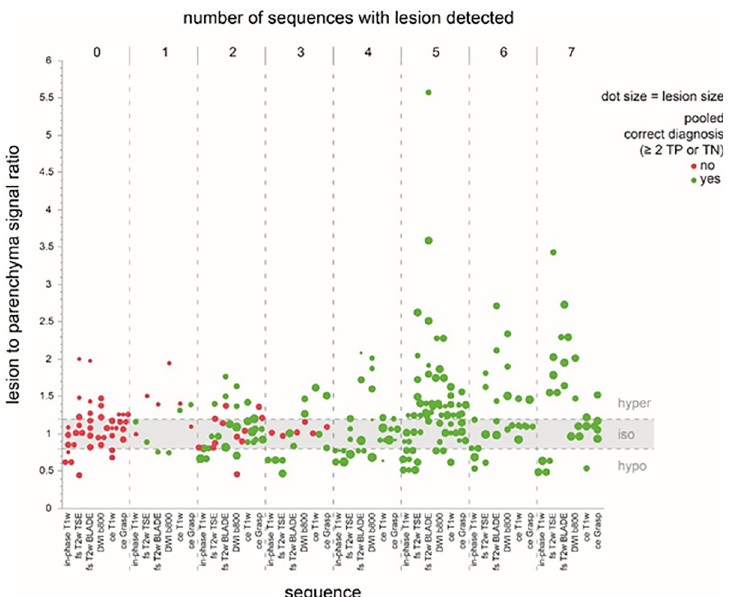
Fig 2. Relationship of number of sequences to correct diagnosis. The graph shows the number of sequences a lesion was detected on in relation to the measured lesion to parenchyma signal ratio. The higher the number of sequences a PICT was identified on, the more often a correct diagnosis was made. If a lesion was detected on four or more sequences, there was no missed lesion. This indicates increasing confidence in declaring a lesion to be present if detected on a larger number of sequences. Furthermore, the majority of missed lesions resides in the “iso” signal ratio corridor indicating poorly visible lesions. Correct diagnosis is indicated as green dot, wrong diagnosis as red dot. Dot size correlates with PICT size. Graph shows PICTs with obtainable measurements on imaging, therefore false positive lesions are not represented. T2w Haste coronal and axial as well as coronal ce T1w Dixon VIBE sequence are not depicted in this